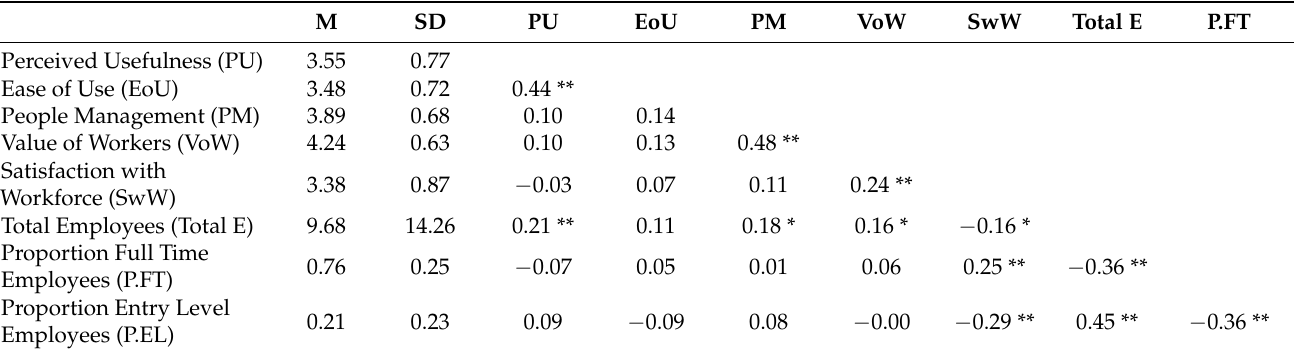
Table 4. Correlations between technology adoption scales, attitudes to workforce scales and work- force structure. Bold denotes a statistically significant correlation where * = p < 0.05 and ** = p < 0.01. M = mean, SD = standard deviation.